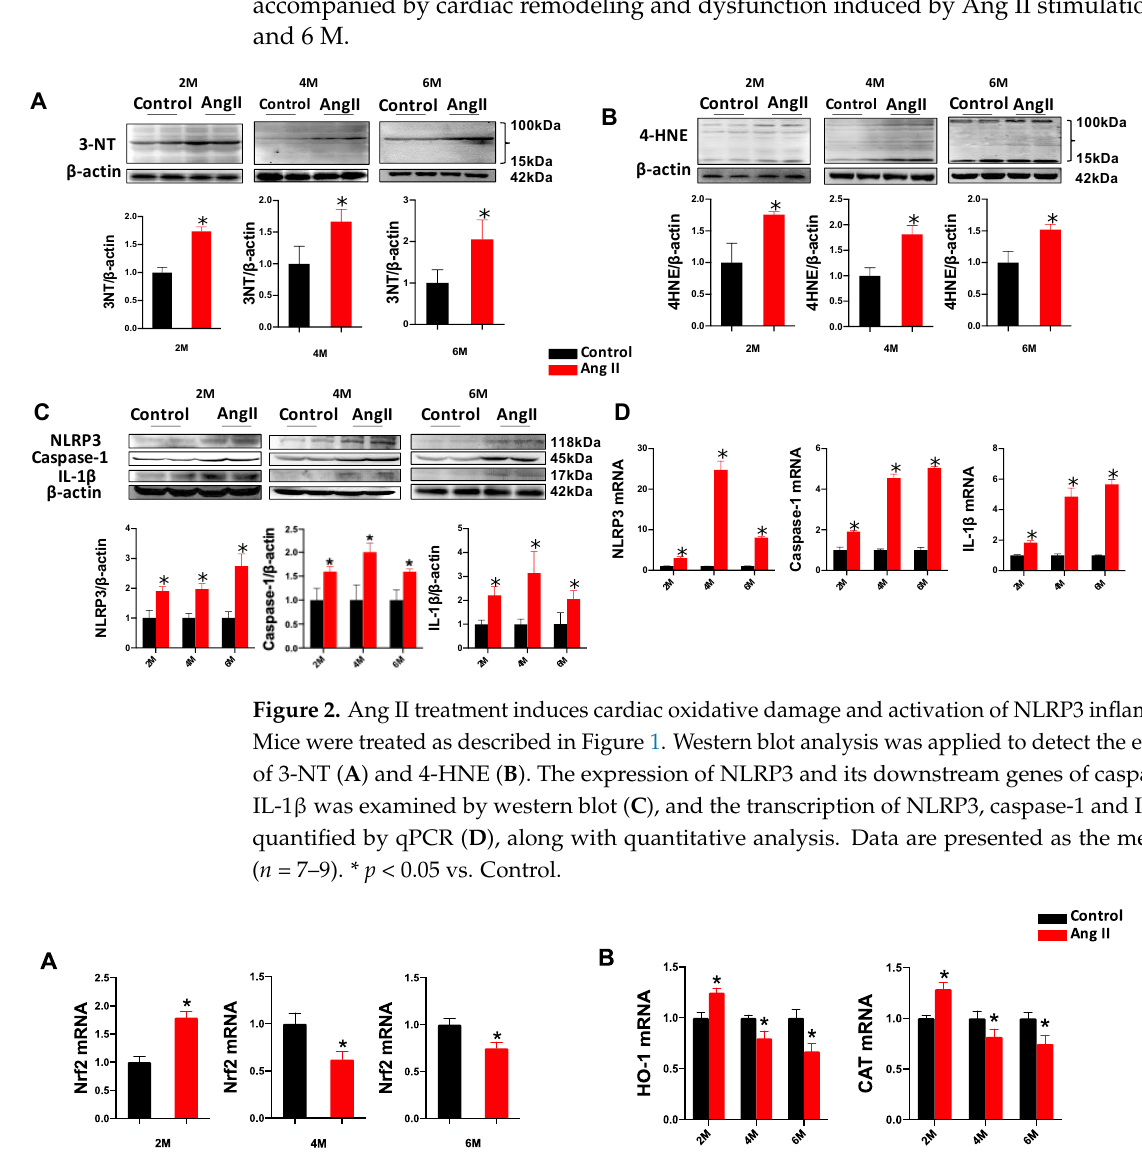
These results suggested that the transcriptional activity of Nrf2 and MHRT was impaired, accompanied by cardiac remodeling and dysfunction induced by Ang II stimulation at 4 M and 6 M.